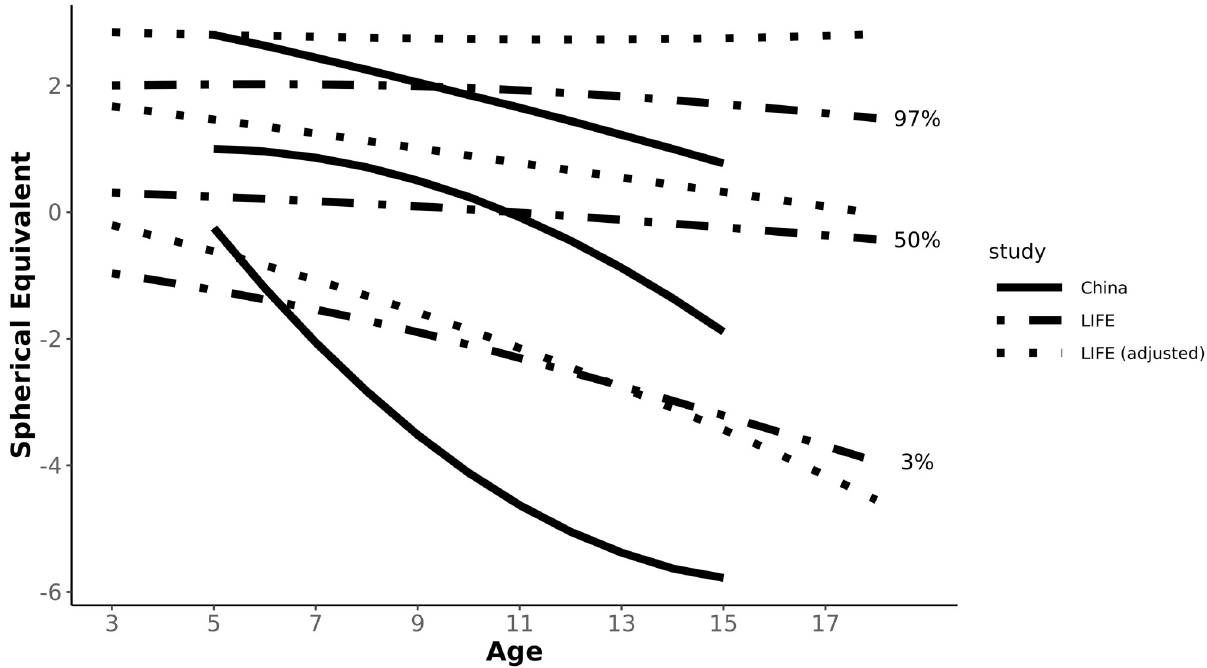
Fig 3. 3 rd , 50 th , 97 th centile reference curves of refraction over age for girls. The dashed lines represent the data of the LIFE Child study, the dotted lines the transferred data of LIFE Child study by the calculation of Sakaridurg et al. into comparable data for cycloplegia and the continous lines show the results of the RESC study from a city in China [3].